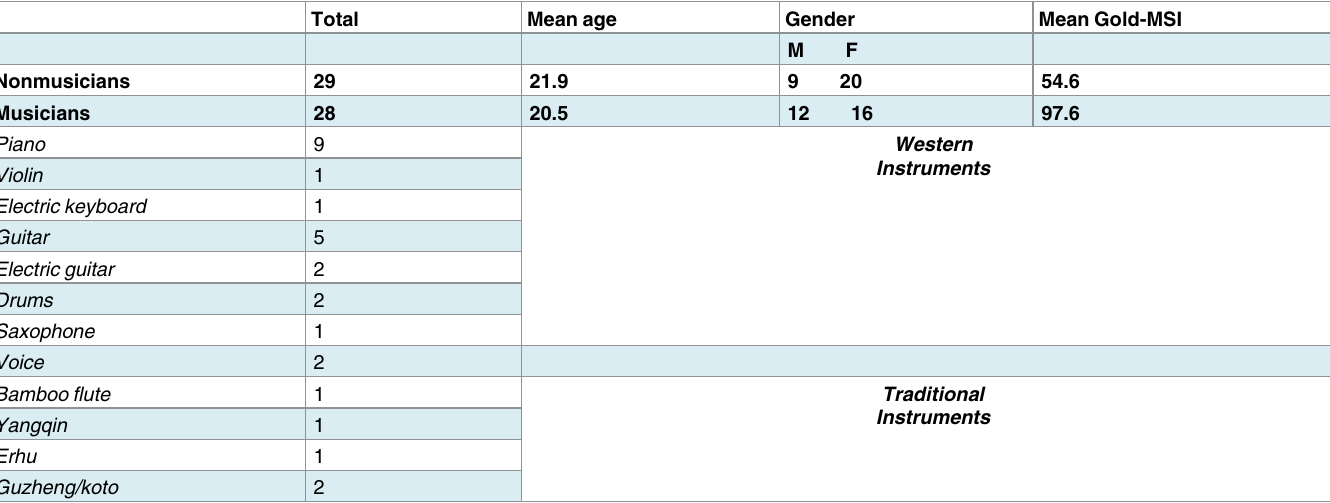
Table 1. Description of participants: group designation, age, gender, Gold-MSI scores, and primary instruments of